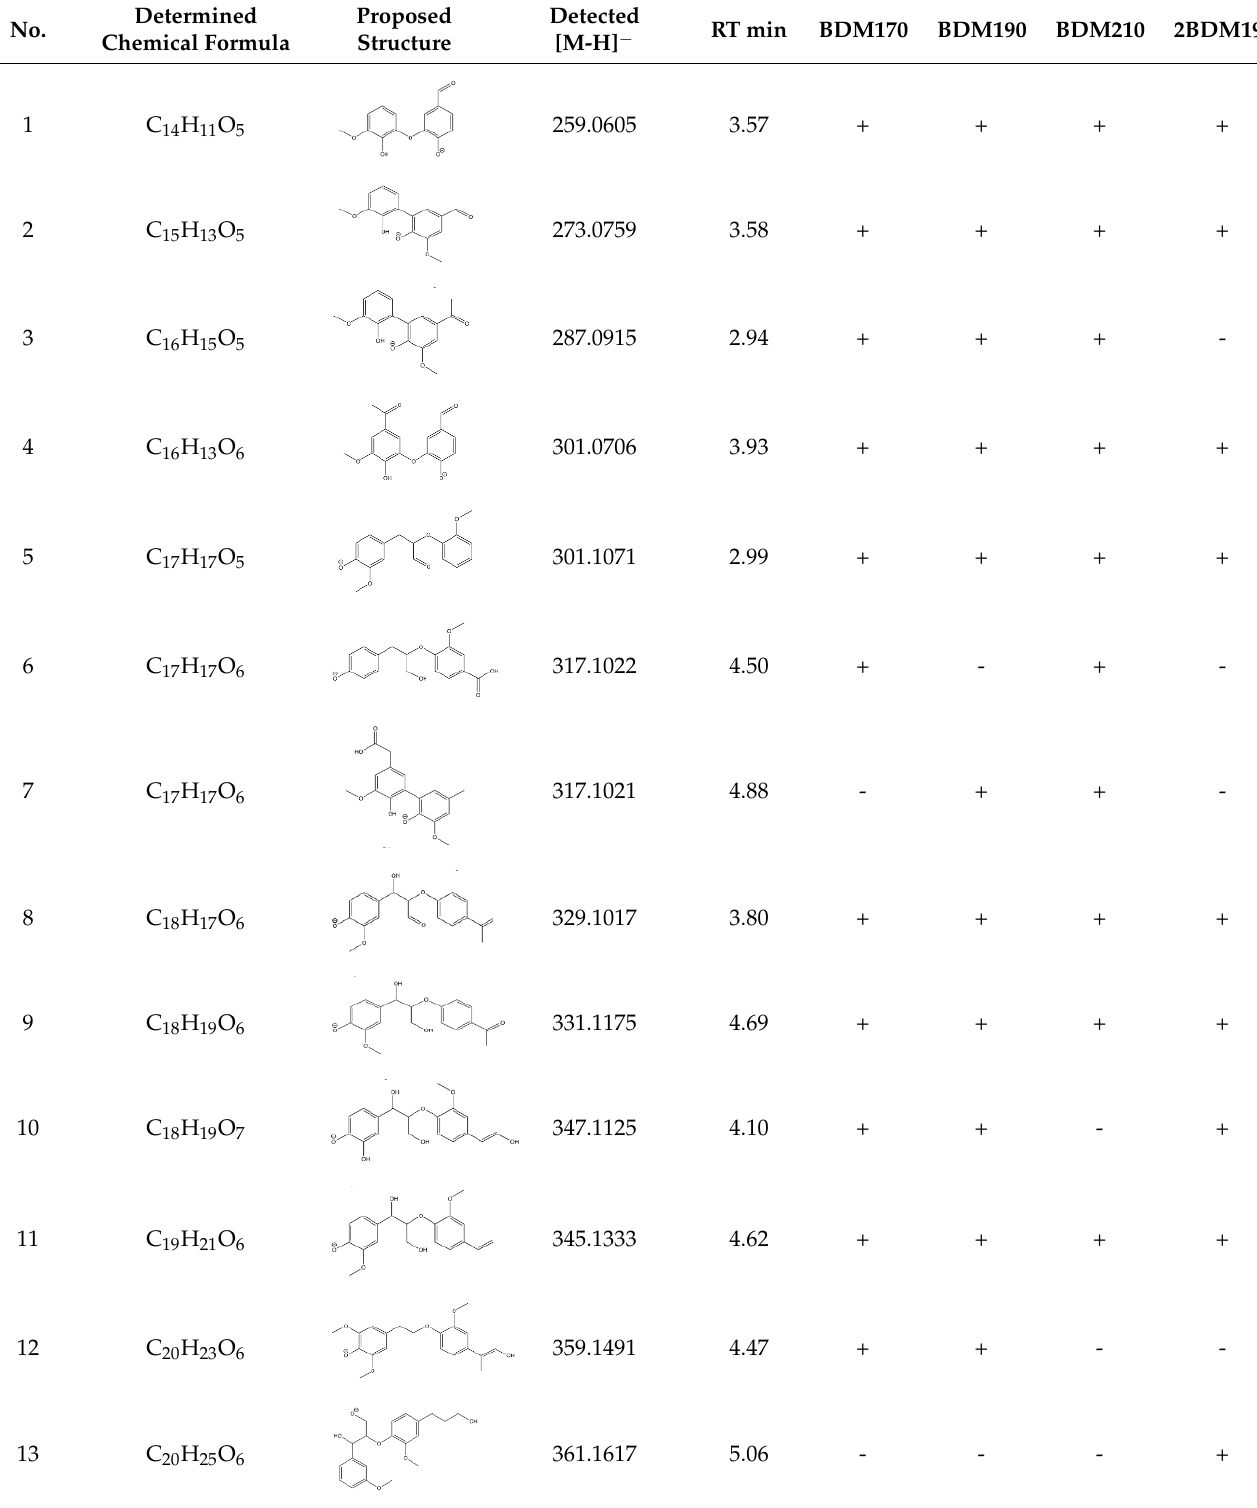
Table 2. Overview of obtained tentative structures of dimers detected in the BDM170, BDM190, BDM210, and 2BDM190 samples (+:present; -: not present).